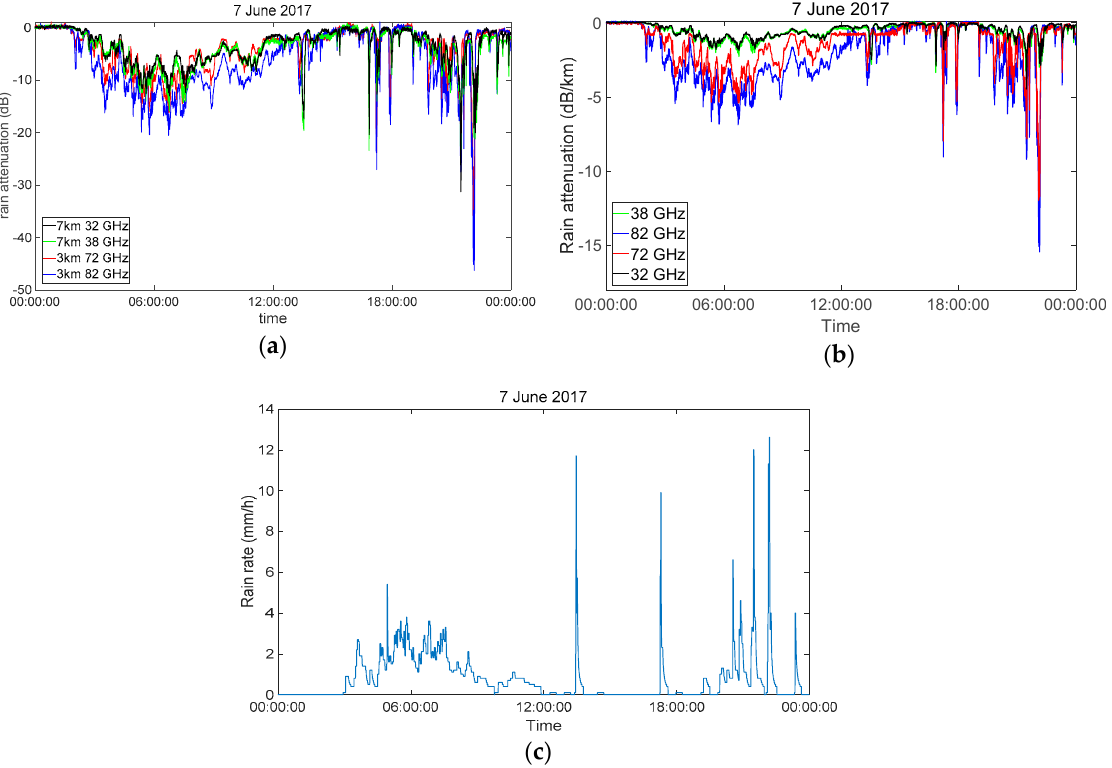
Figure 4. The measurement setup and locations in Gothenburgh, Sweden: ( a ) received signal variation of the test links on June 7, 2017; ( b ) received signal variation of the test links averaged over 1 km distance; ( c ) rain rate monitored by a rain gauge.